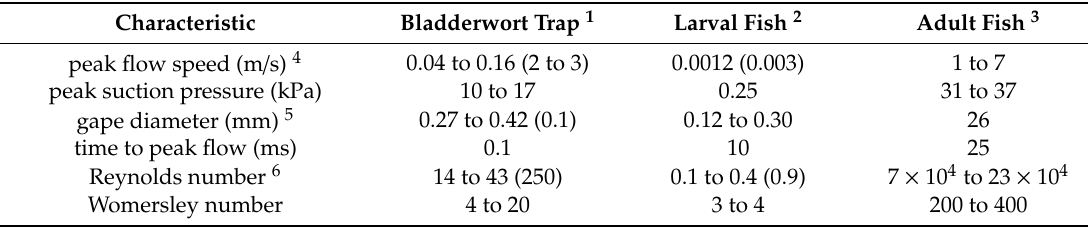
Table 1. Suction characteristics of bladderwort traps and